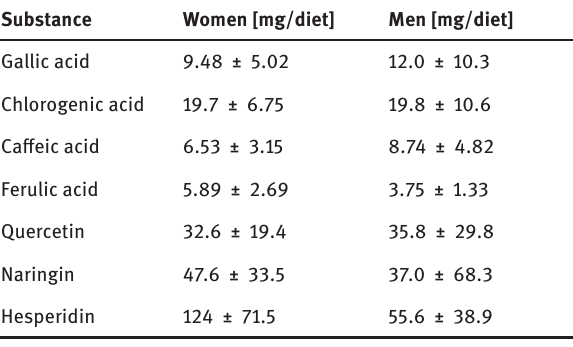
Table 4: Average intake of phenolic compounds among women and men (3 years study period).